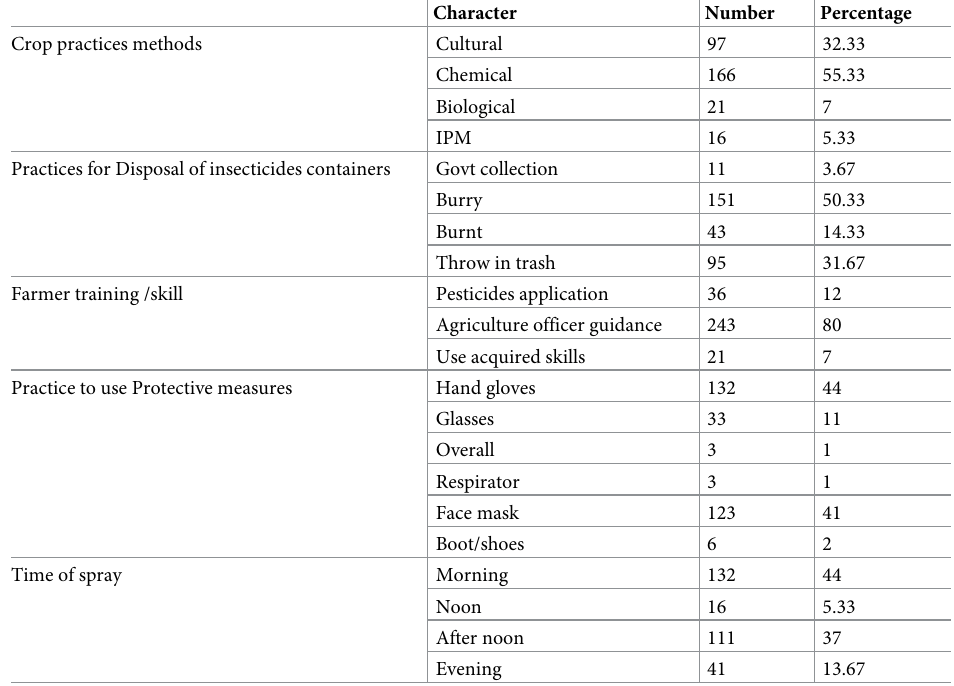
Table 3. Common practices of respondents in three localities of province Punjab Pakistan (n =